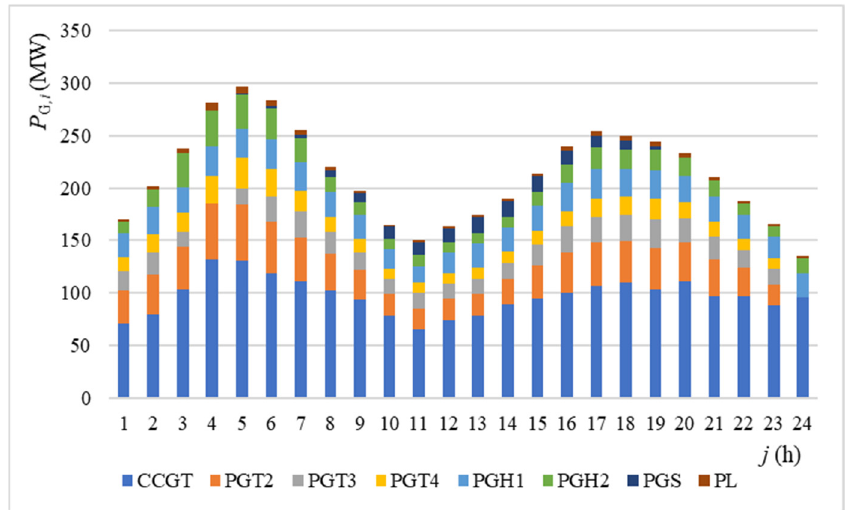
Figure 10. Optimal generation scheduling for case 1–sub-case 2.